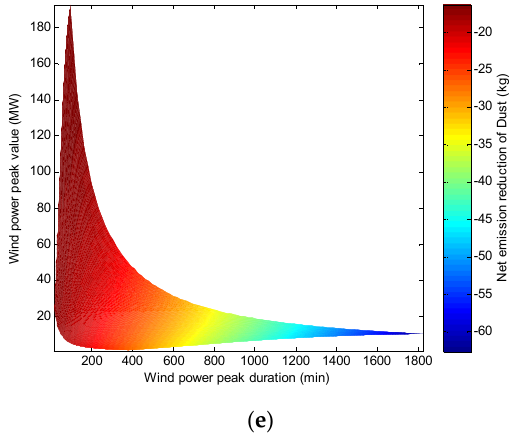
Figure 9. Net profit and net emission reduction of the wind–coal combined power generation system of strategy (3) against wind energy curtailment for wind power peaks above 240 MW. ( a ) Net profit; ( b ) Net coal consumption reduction; ( c ) Net emission reduction of CO 2 ; ( d ) Net emission reduction of NO x ; ( e ) Net emission reduction of dust.